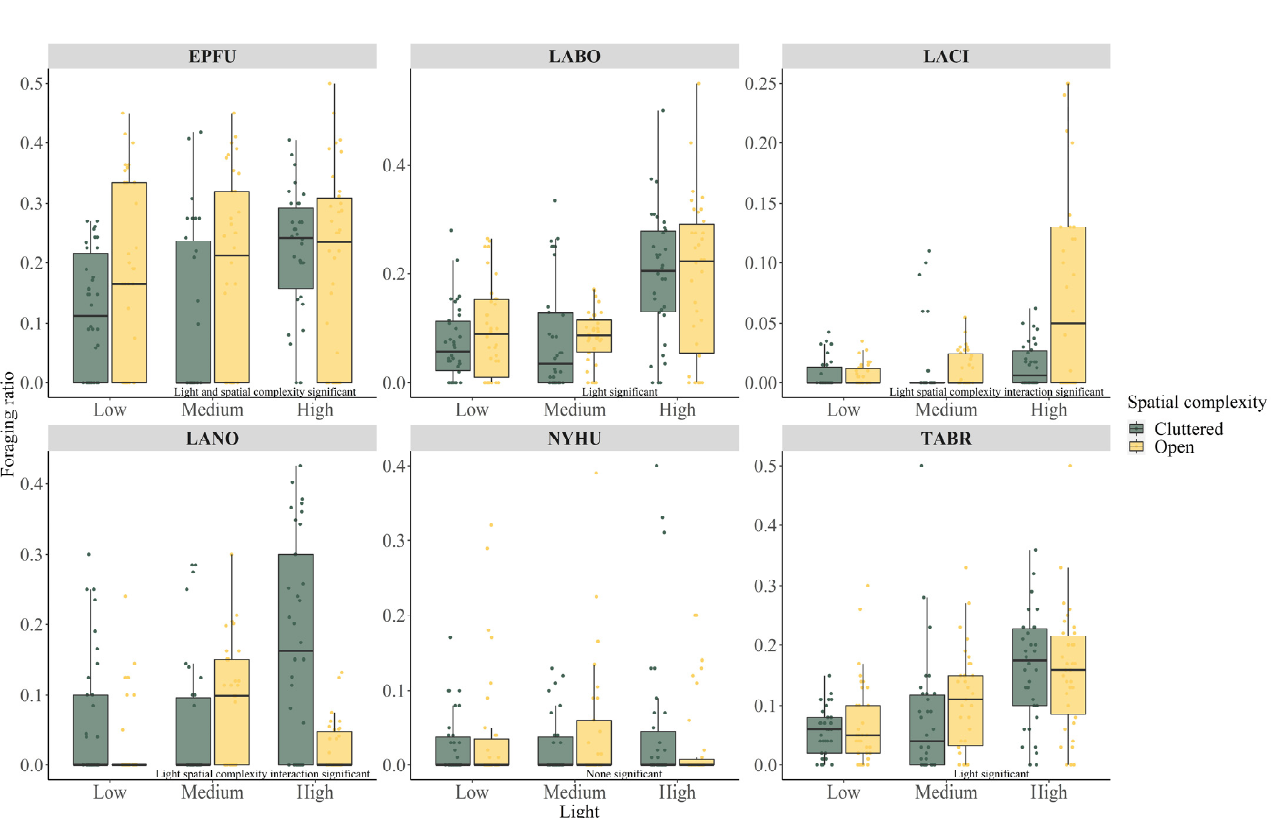
Figure 3. Boxplots (25th, 50th, 75th percentiles) and raw data points of species-specific foraging ratio at sites of varying ALAN levels and spatial complexity. Independent variable significance is annotated in the graph. Species abbreviations: big brown bat ( Eptesicus fuscus , EPFU), eastern red bat ( Lasiurus borealis , LABO), hoary bat ( Lasiurus cinereus , LACI), silver-haired bat ( Lasionycteris noctivagans , LANO), cave myotis ( Myotis velifer , MYVE),eveningbat( Nycticeius humeralis , NYHU),tricoloredbat( Perimyotissubflavus , PESU), and Mexican free-tailed bat ( Tadarida brasiliensis , TABR). Independent variable significance is annotated in the